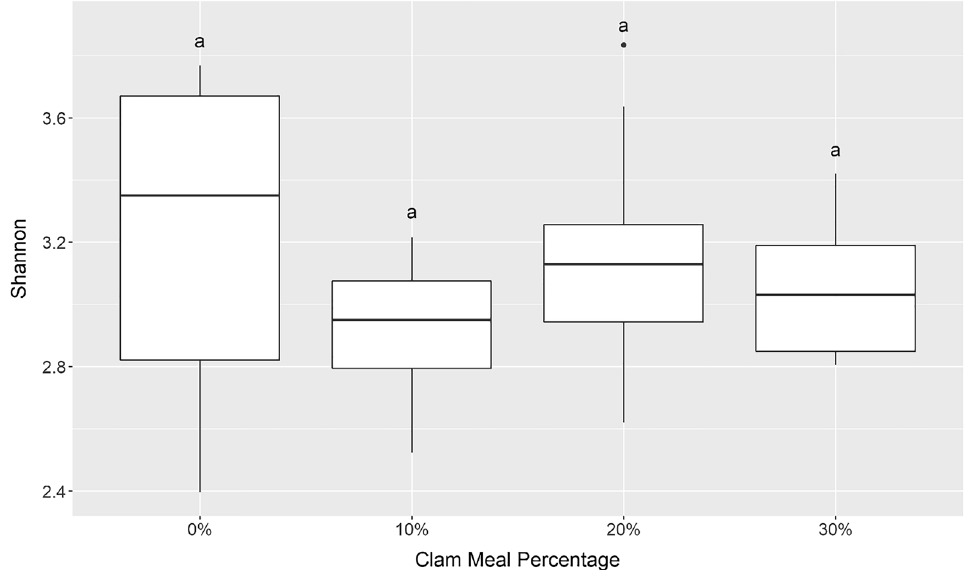
Figure 6. Boxplots summarizing Shannon diversity by diet. Bars denote largest and smallest values within 1.5 times the interquartile range, middle line is the median, ends of boxes are the first and third quartiles. Letters above the boxplots indicate results of pairwise Dunn testing with Benjamini–Hochberg (BH) adjusted p-values. If there is a shared letter between boxplots, that means that they were statistically similar (BH adj. p-value >